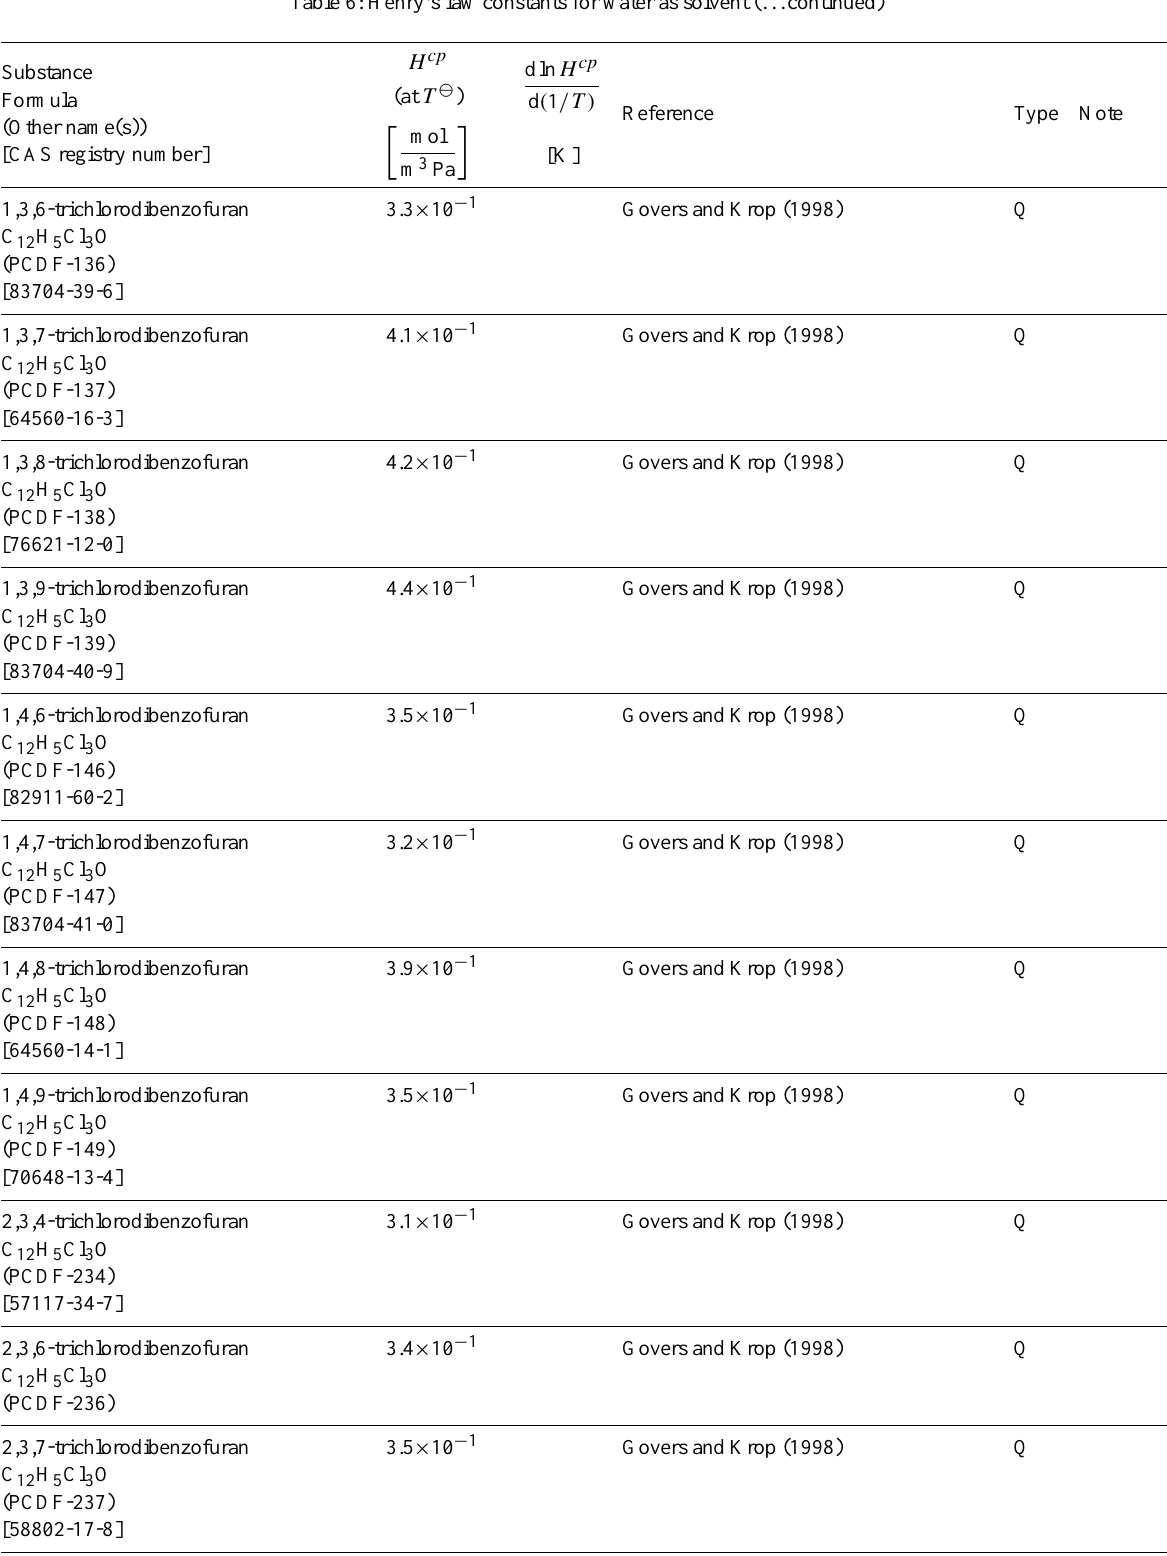
Table 6: Henry’s law constants for water as solvent